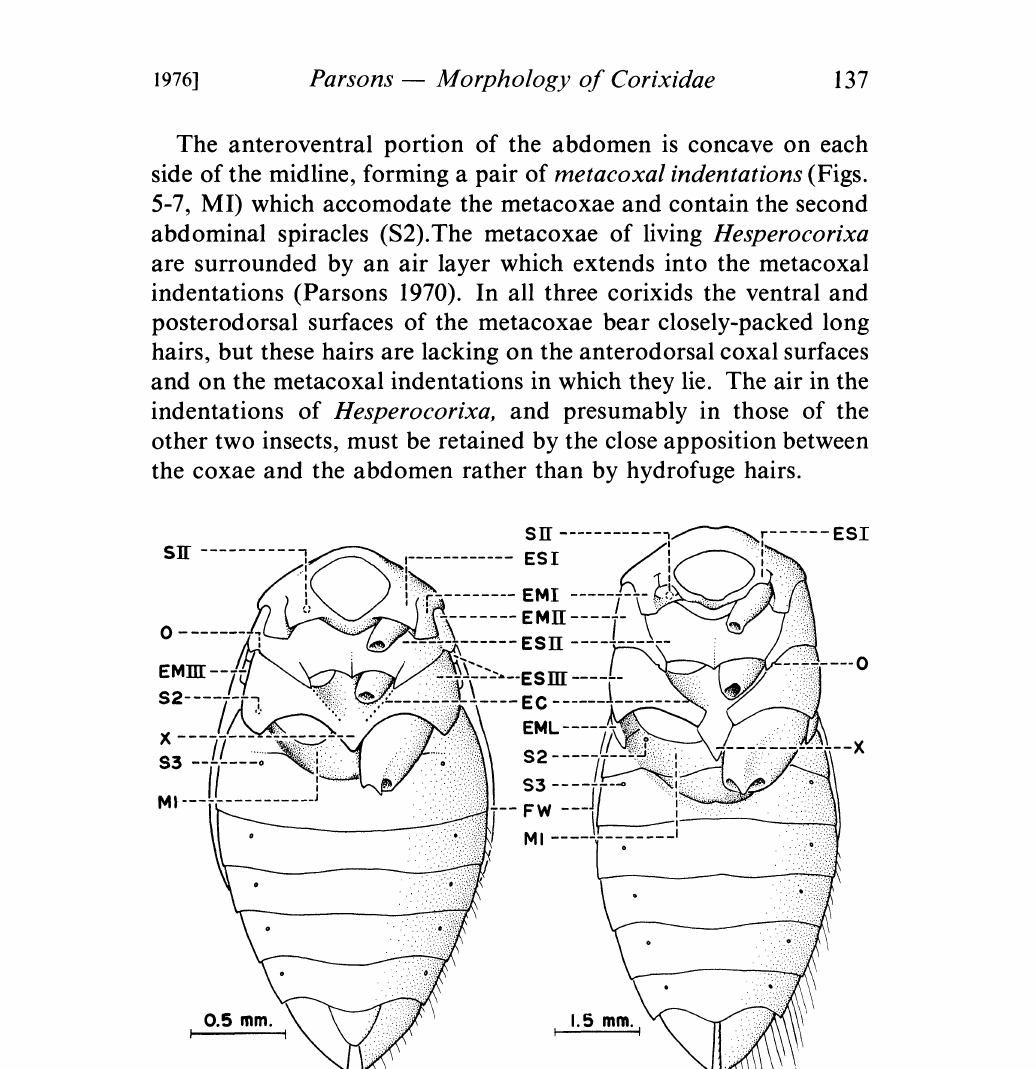
Fig. 6. M. sedula, ventral view, prepared as in Fig. 5. Second abdominal spiracle ($2) concealed by lobe of metathoracic episternum. Efferent channel (EC) of meta- thoracic scent gland, indicated by dotted lines, lies beneath exoskeleton. Fig. 7. H. interrupta, ventral view, prepared as in Fig.